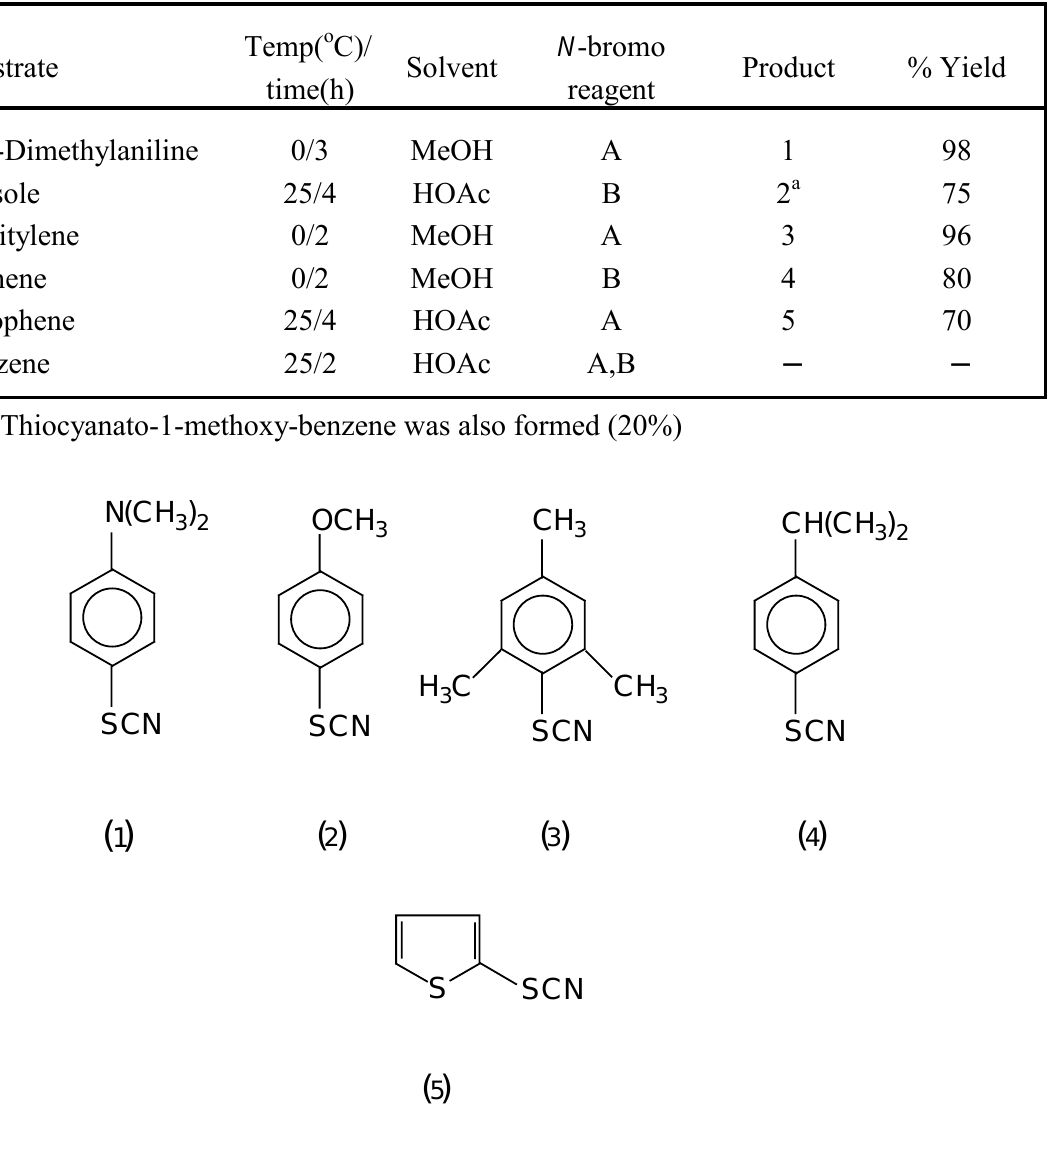
Table: Preparation of aryl